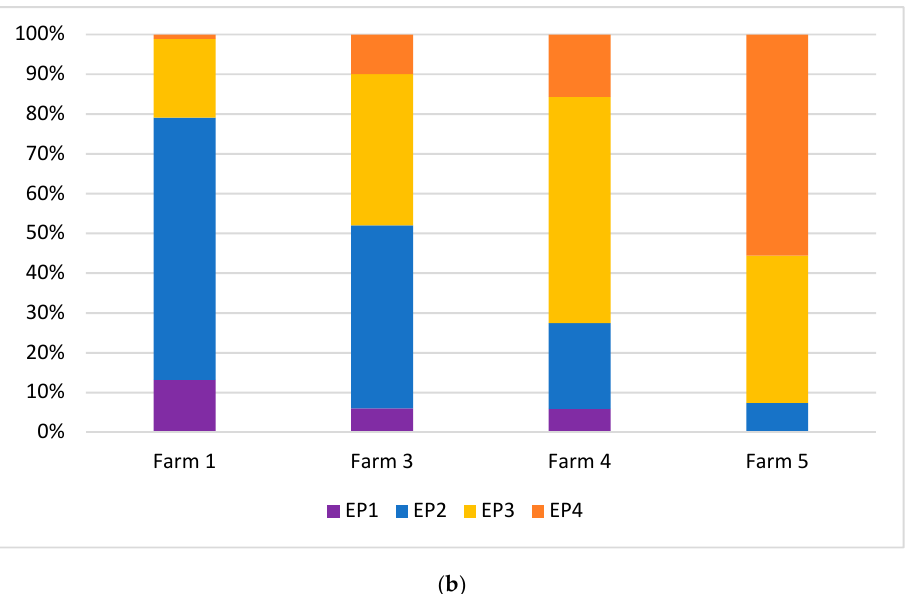
Figure 7. Results of the ear posture in the farms included in the study. ( a ) during feeding; ( b ) during resting.